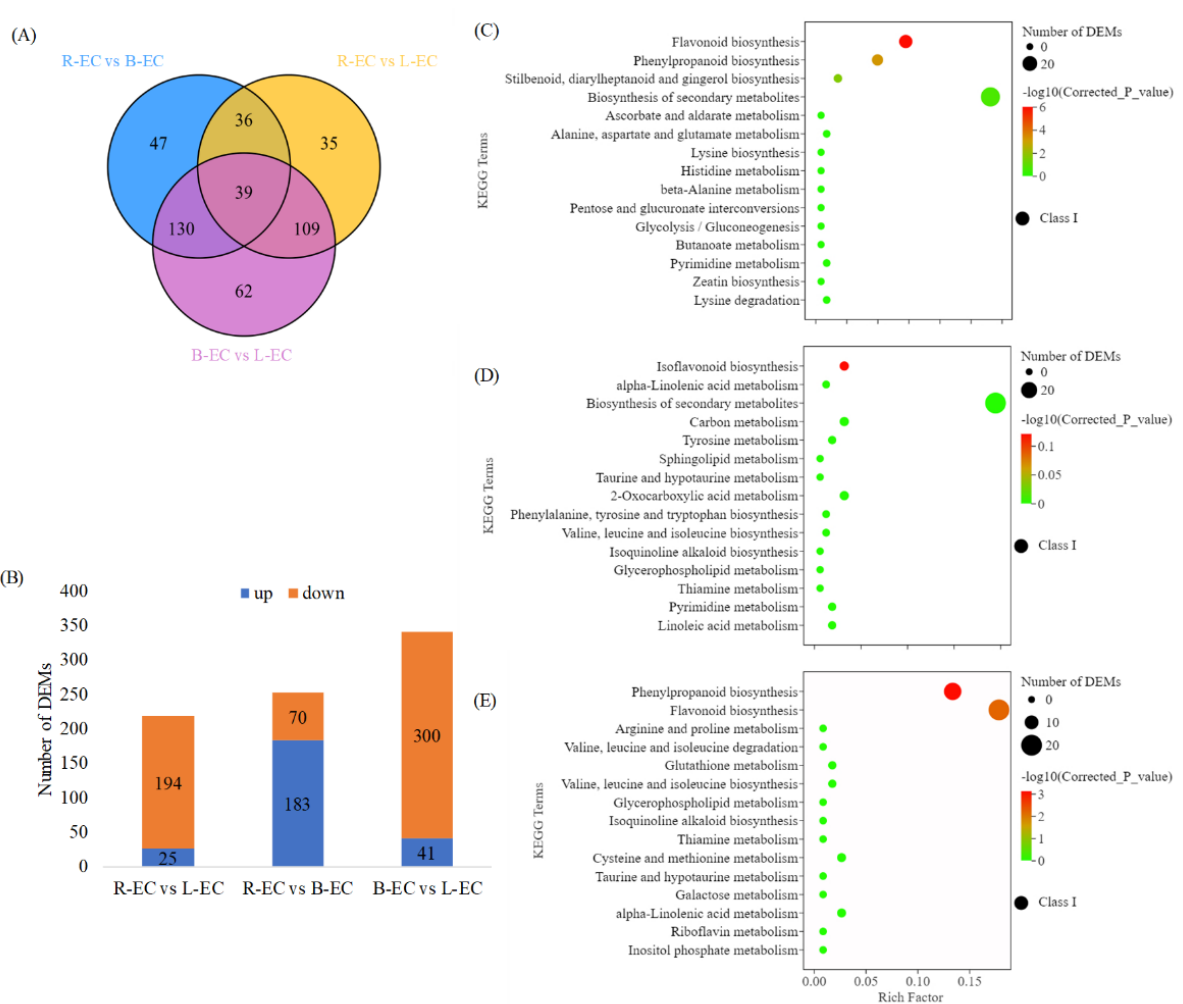
Figure 7. Statistical analysis of differentially expressed metabolites (DEMs) among R-EC, L-EC, and B-EC Korean pine cell lines. ( A ) Venn diagram showing the number of DEMs between different tissues. ( B ) Statistics on the number of DEMs when comparing different tissues. ( C – E ) DEMs enriched in different KEGG